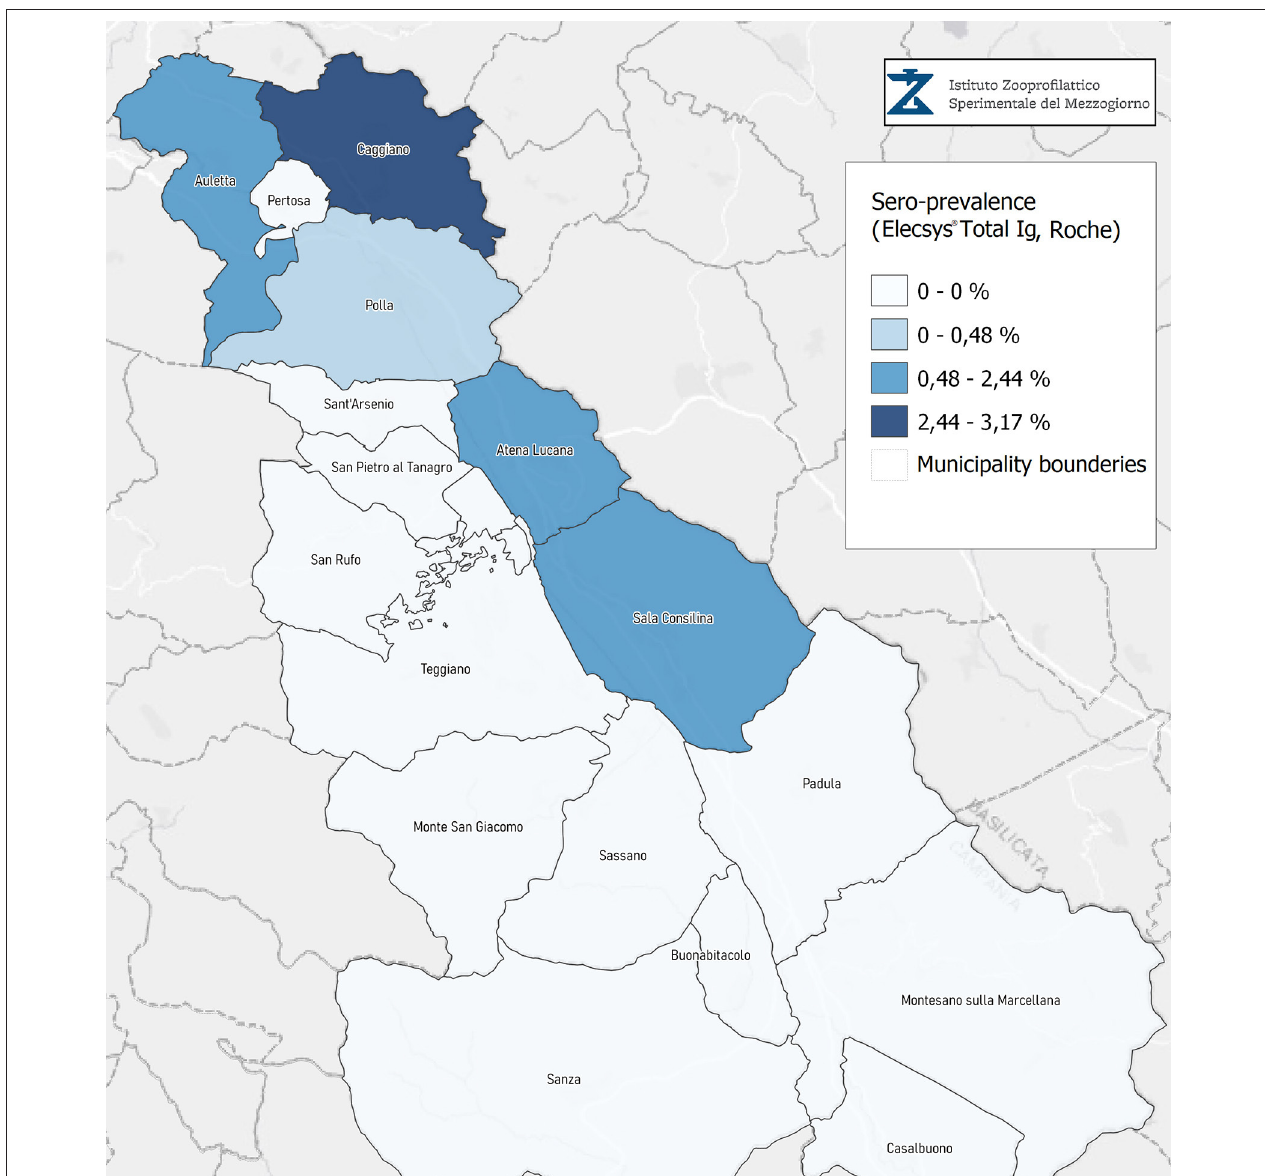
FIGURE 3 | Seroprevalence assessed in Diano Valley municipalities by Elecsys Total Ig Roche.